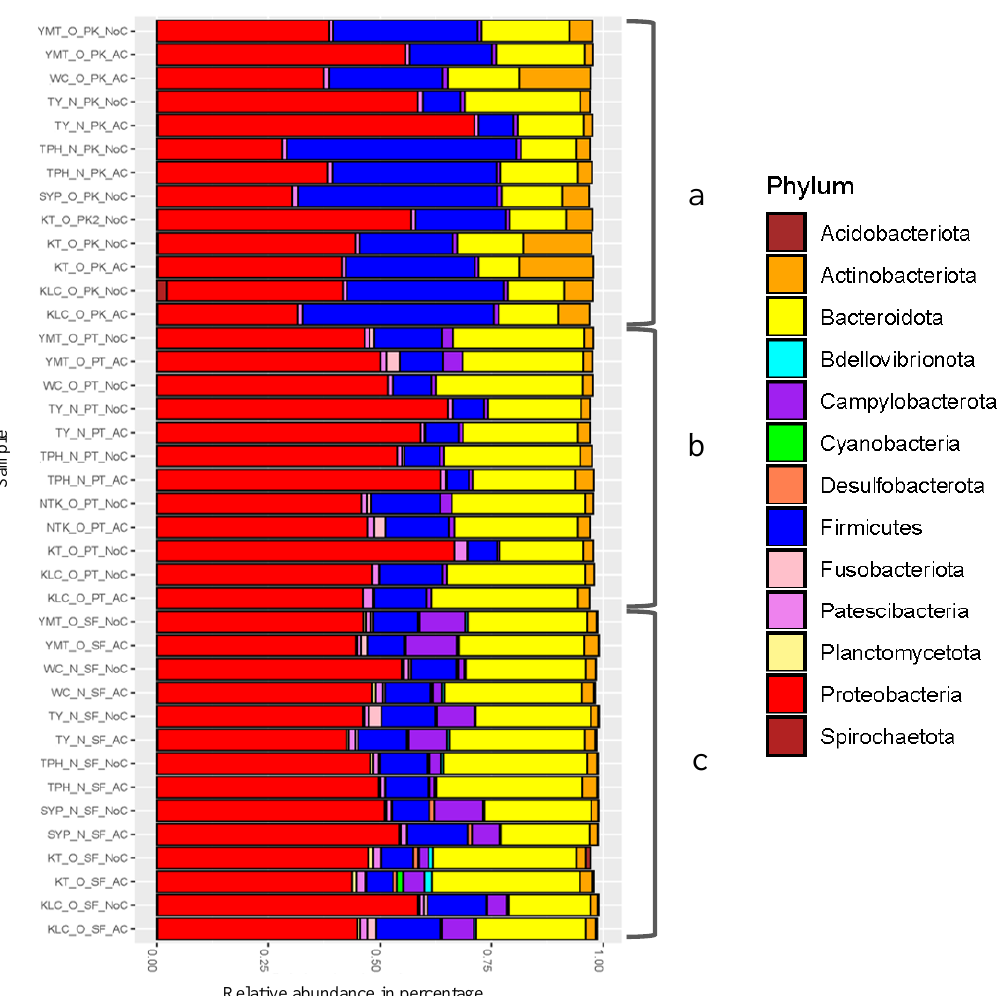
Figure 2. Taxonomic profile: Relative phylum-level abundance of bacteria in samples from wooden cutting boards used for di ff erent food groups: ( a ) pork, ( b ) poultry, and ( c ) seafood. Meta-Analysis of Bacterial Community Composition on Wooden Cutting